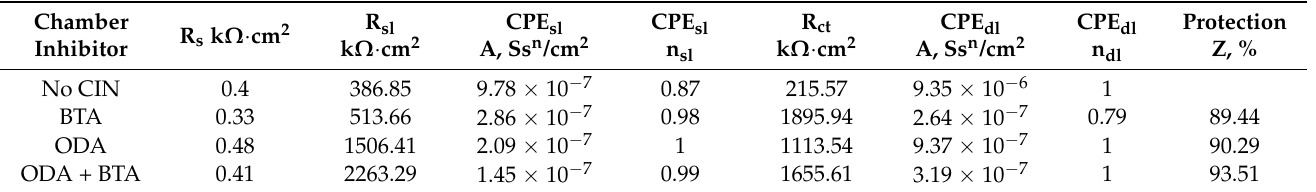
Table 5. Values of equivalent circuit elements based on the results of impedance spectroscopy, as calculated for different variants of copper CT. T CT = 100 ◦ C, and τ CT = 60 min.